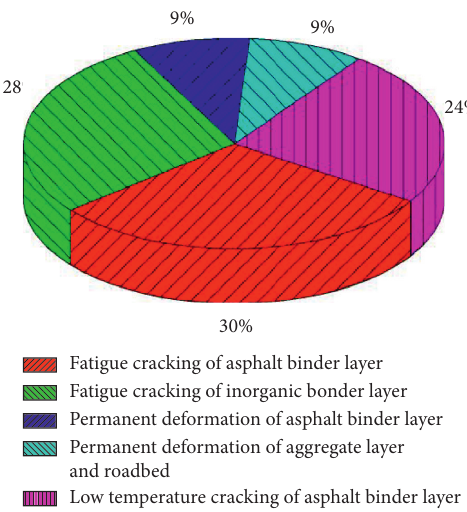
Figure 3: Types and proportions of main pavement degradations.